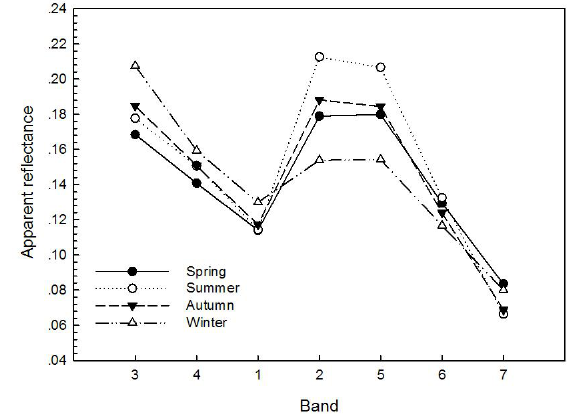
Figure 3. Variation of apparent reflectance with seven MODIS wavebands in four